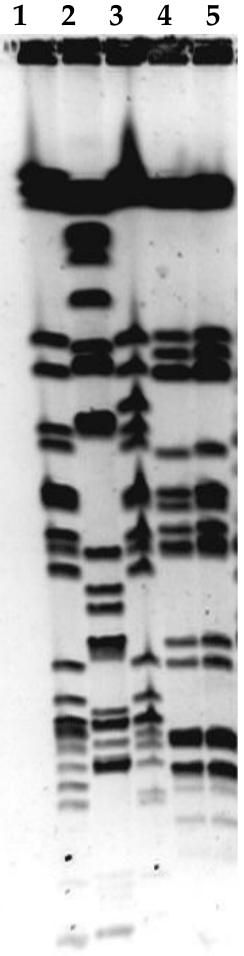
Figure 2. Transmission electron micrographs of K. pneumoniae phages LASTA ( a ) and SJM3 ( b ). A thin collar structure beneath the capsids is indicated by the arrows and a distal disc structure composed of numerous globular appendages is labelled with triangles.